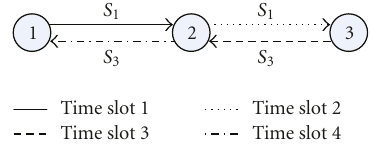
Figure 2: Traditional scheduling scheme.